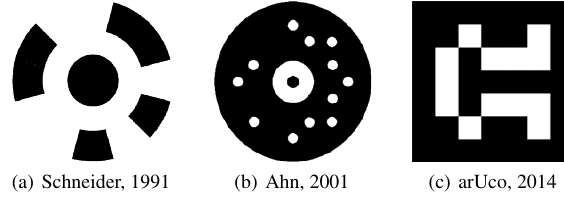
Figure 1: Examples of fiducial targets commonly employed in robotics and photogrammetry